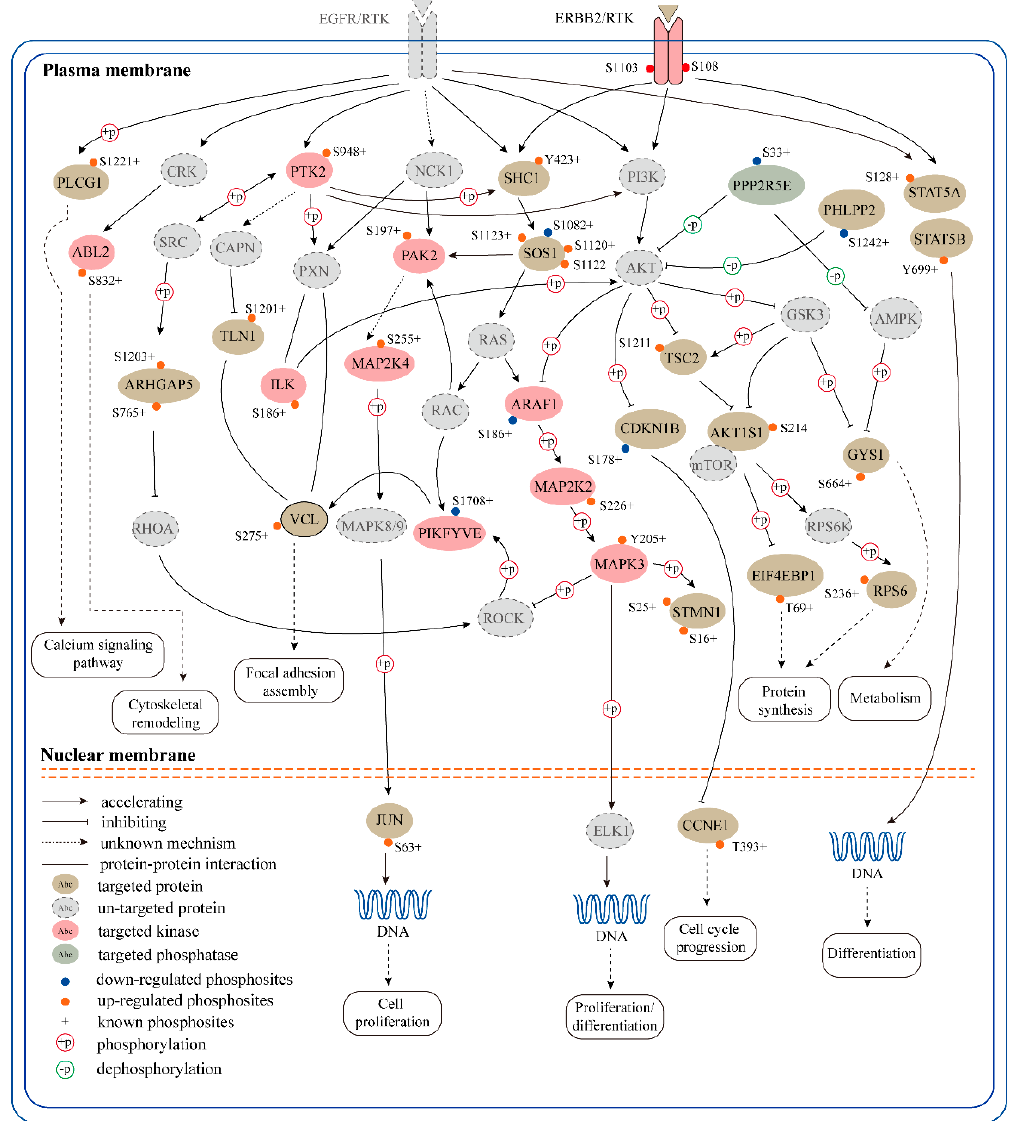
Figure 5. SPRY-altered signaling network profiles in mammary stromal fibroblasts. A phosphorylation network centered on receptor tyrosine kinase (RTK) signaling cascades was reconstructed according to KSR and KEGG pathway enrichment. The biological processes underlying the pathway network, such as cytoskeleton remodeling, cell proliferation and cell cycle progression, are shown in the schematic diagram. Khaki ellipses indicate targeted proteins, while gray ellipses indicate un-targeted proteins in this study. Kinases and phosphatase inhibitors are shown in pink and gray-green ellipses, respectively. Orange dots represent up-regulated phosphosites and down-regulated phosphosites are marked with blue dots and previously reported phosphosites are labeled with “ + ”. The di ff erent line types indicate di ff erent regulation mechanisms between two proteins. Phosphorylating and dephosphorylating relationships are also illustrated in the diagram with red and green circles,